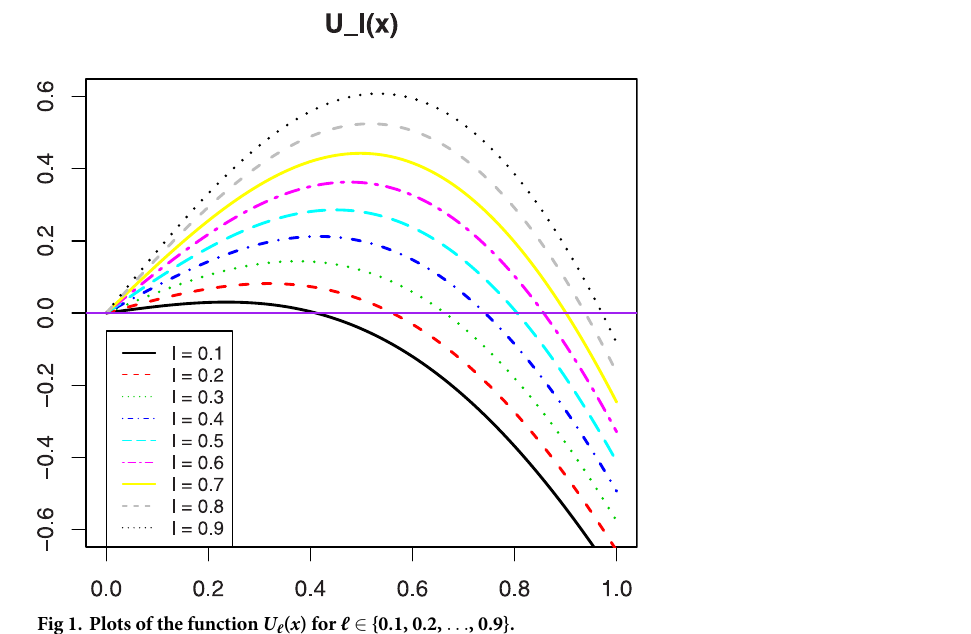
Fig 1. Plots of the function U